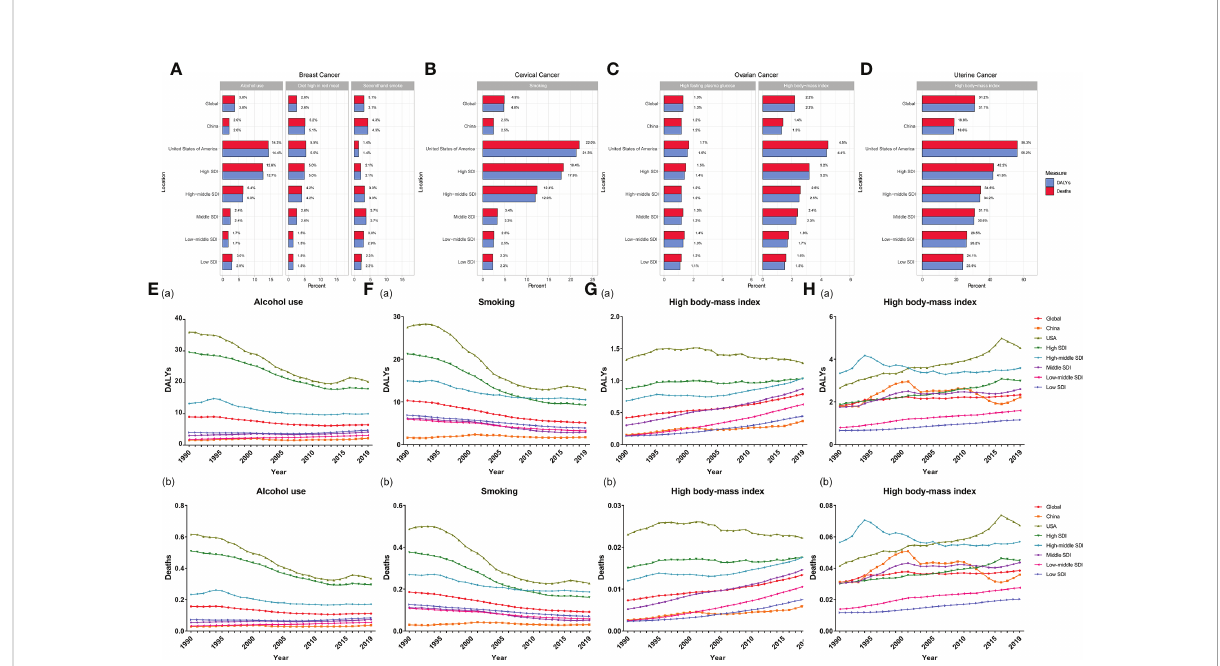
FIGURE 4 Percentage of factors for FeBGCs among AYAs in 2019 and attributive rates in 1990 – 2019. (A) Percentage of alcohol use, diet high in red meat, and secondhand smoke for female breast cancer; (B) percentage of smoking and unsafe sex for cervical cancer; (C) percentage of high fasting plasma and high body mass index for ovarian cancer; (D) percentage of high body mass index for uterine cancer; (E) rates of DALYs (a) and deaths (b) attributable to alcohol use for breast cancer; (F) rates of DALYs (a) and deaths (b) attributable to smoking for cervical cancer; (G) rates of DALYs (a) and deaths (b) attributable to high body mass index for ovarian cancer; (H) rates of DALYs (a) and deaths (b) attributable to the high body mass index for uterine cancer; ARP, attributable risk percent; AYAs, adolescents and young adults; DALY, disability-adjusted life years; FeBGCs, female breast and gynecologic cancers; SDI, social-demographic